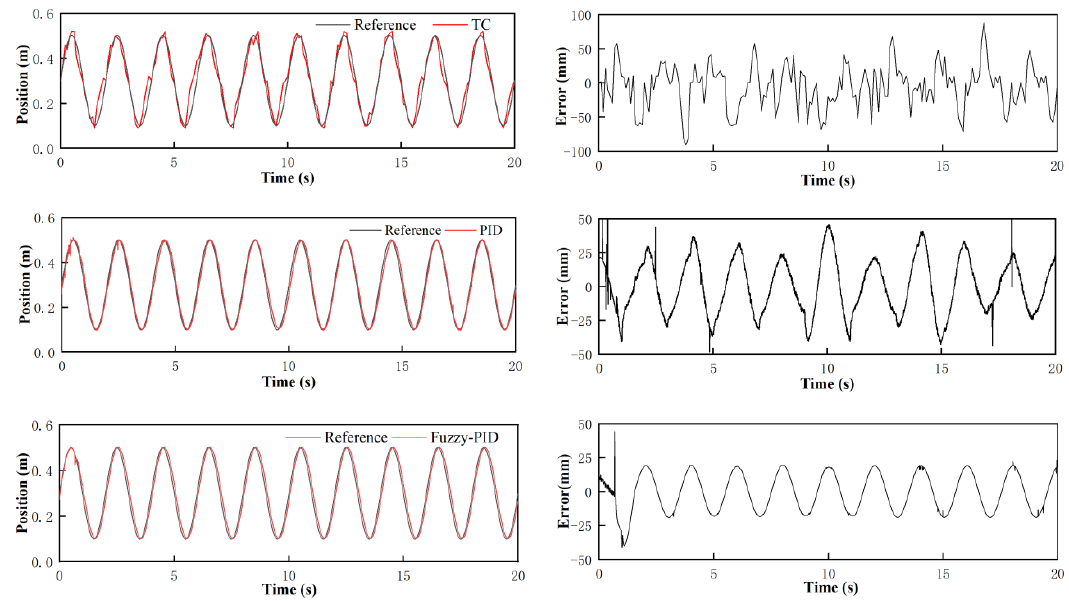
Figure 16. Experiments of normal-level trajectory motions (Constant Forging).